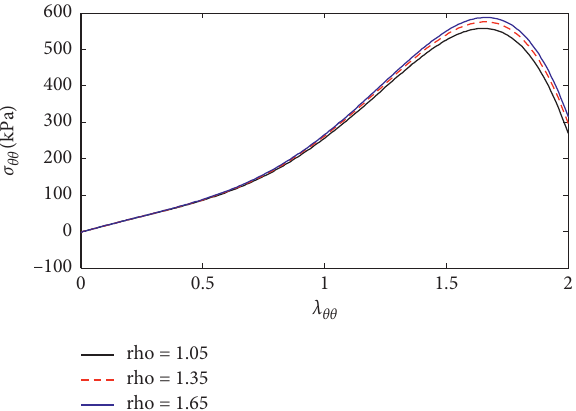
Figure 13: Influence of blood density on circumferential stress.